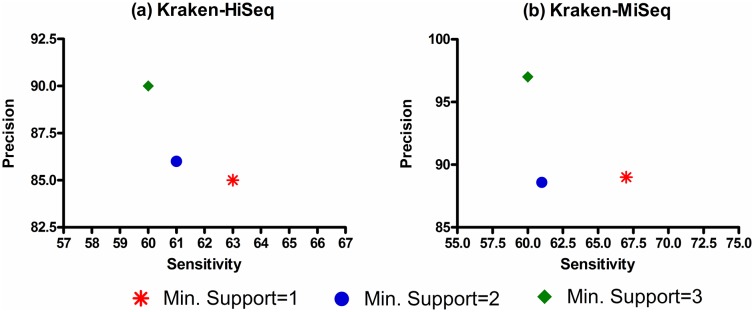
The sensitivity and precision at the species level for the WEVOTE (N = 5) using different thresholds for the minimum number of tools that support the WEVOTE decision.(a) Kraken-HiSeq dataset; and (b) Kraken-MiSeq dataset.